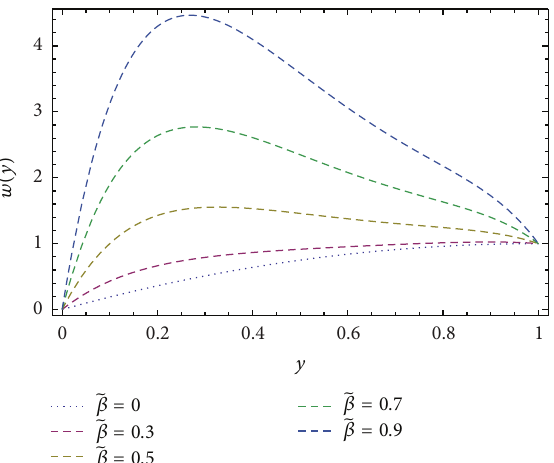
Figure 2: Profile of the nondimensional velocity 𝑢(𝑦) for different ̃𝛽 values of , keeping 𝑃 ,𝑥 = −2.0 , 𝑃 ,𝑧 = −2.0 , and 𝜙 = 45 ∘ .